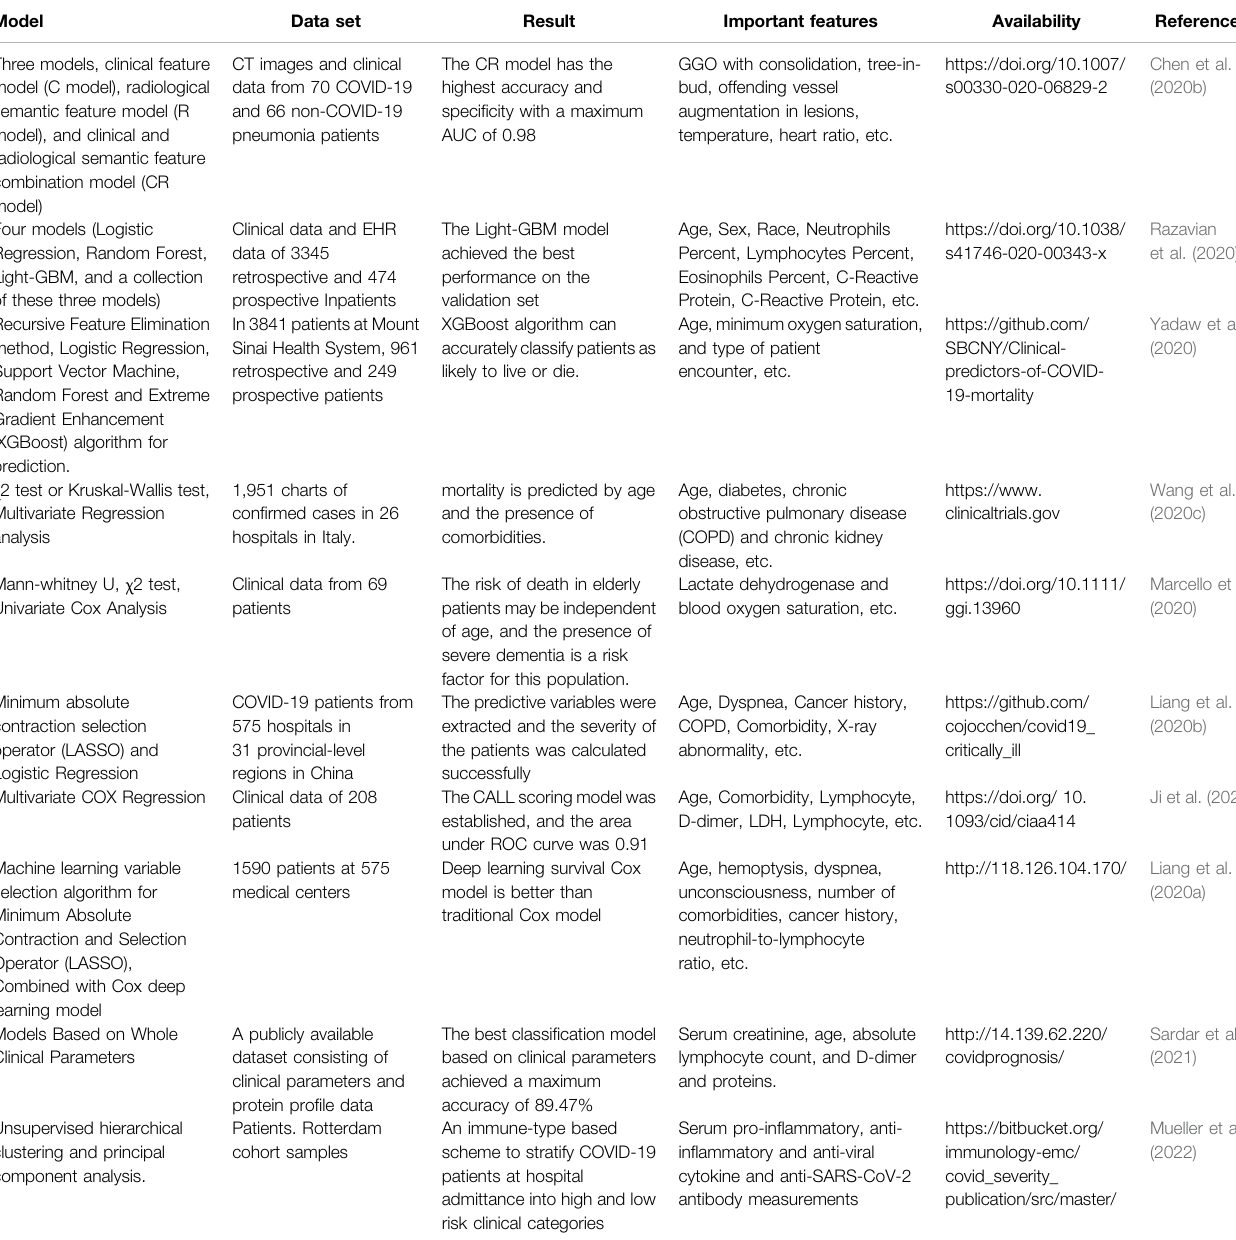
TABLE 2 | Modeling method of EHR